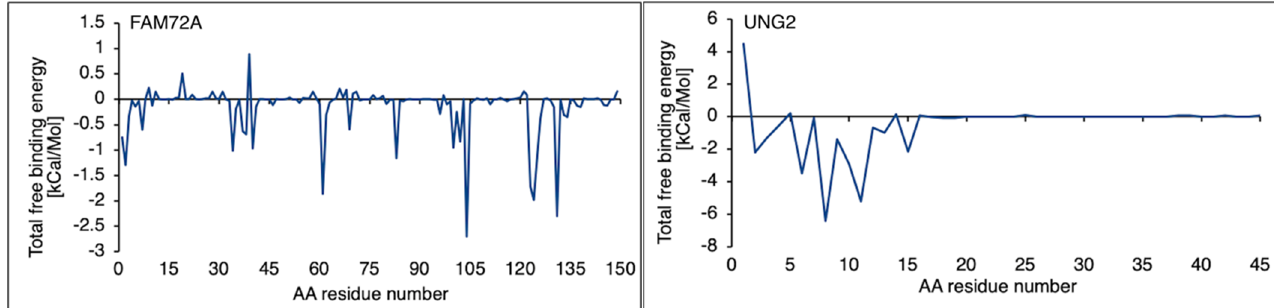
Figure 4. Free binding energy was calculated for the FAM72A protein and UNG2 (AA 1–45) peptide heterodimer interaction. Specific AA residue–residue contact energy calculated the FAM72A-UNG2 (AA 1–45) interaction. Key AA residues were identified in FAM72A (2, 37–40, 61, 83, 101–104, 123–126, and 131, respectively), while AA F104 was identified as a pivotal AA with the highest binding energy contacting the Ser12 and Pro13 AAs of UNG. The UNG2 (AA 1–45) peptide has been verified with only a few AAs accountable for binding contribution (AAs 2, 5, 8, 11, and 15,